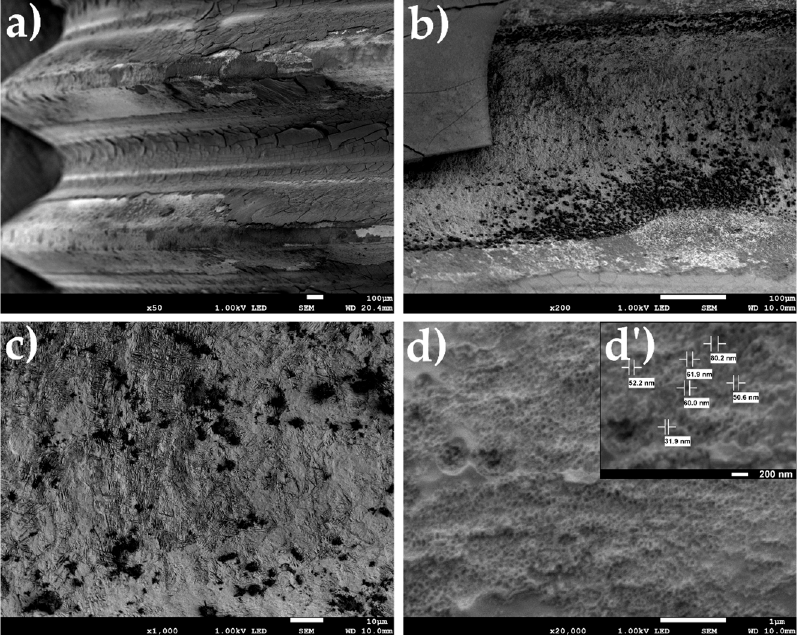
Figure 2. Surfaces of specimens oxidized in an electrochemical way: ( a ) view of specimen, ( b ) surface of helix top, ( c ) surface between top and bottom of the helix, ( d ) bottom of the helix (with different magnifications—d’, with the result of measuring the diameter of nanotubes).